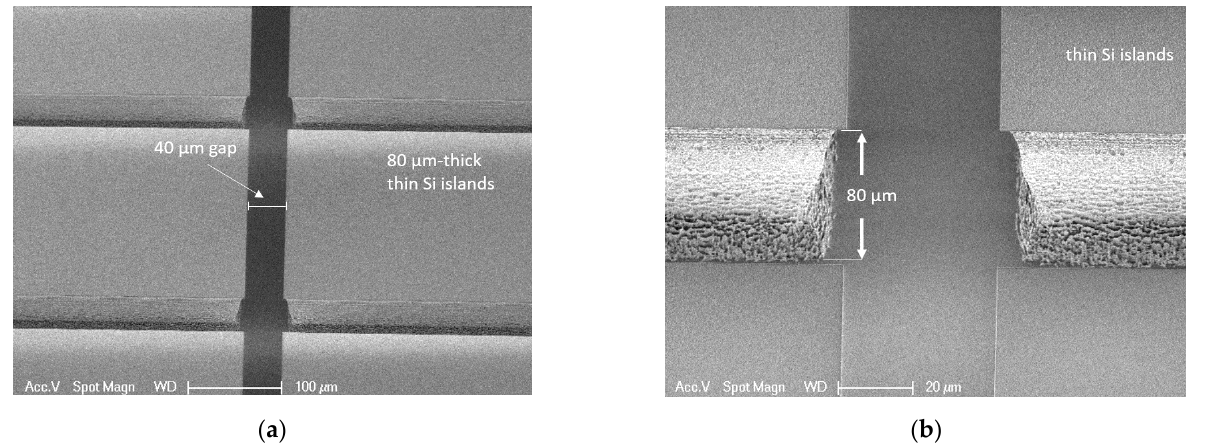
Figure 8. ( a ) SEM image of the 40 µm gaps between the silicon islands. ( b ) Zoom-in image of the 80 µm-thick device layer etching profile, with 6,3 µm under-etch from each side.